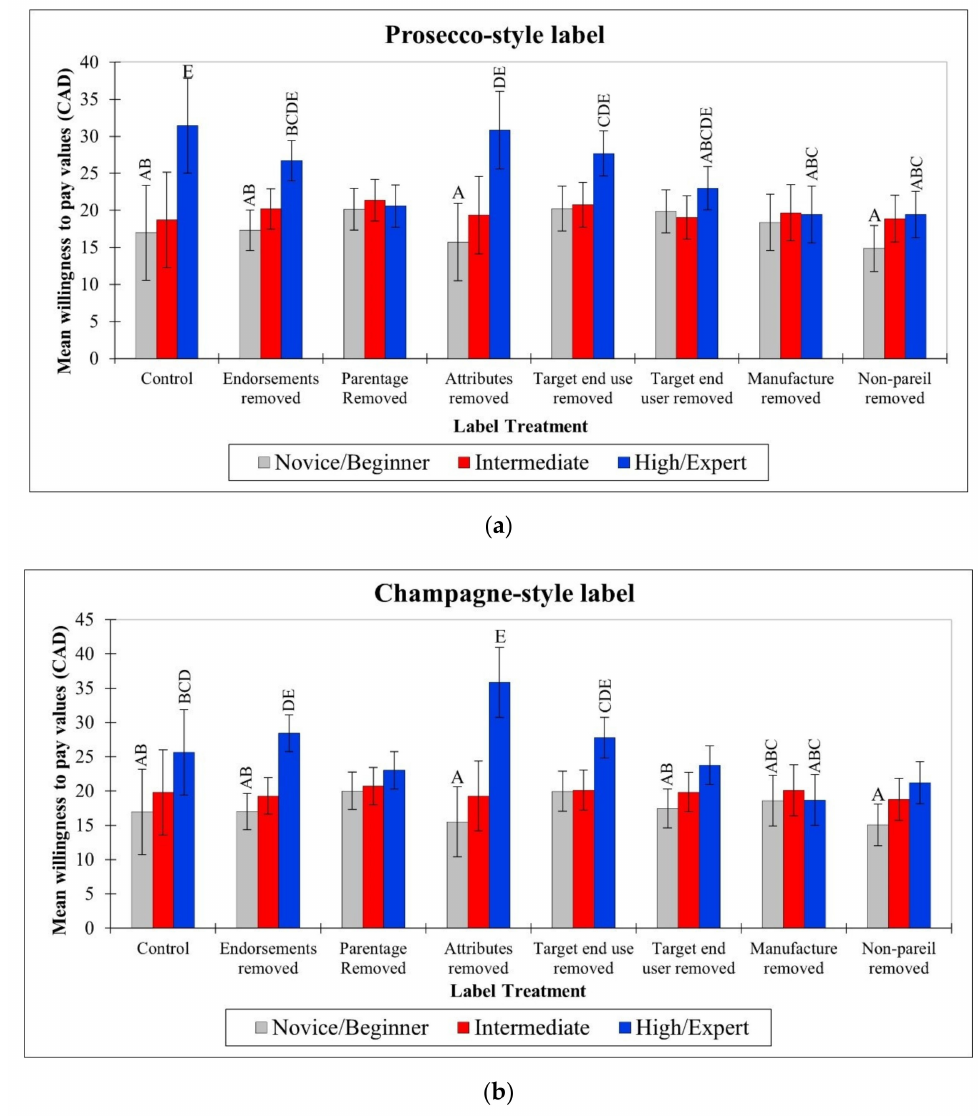
Figure 5. Willingness to pay (CAD, n = 572) +/ − SE for sparkling wine—interaction between label treatments and subjective wine knowledge. Results for ( a ) Prosecco-style wine and ( b ) Champagne- style wine. Letters above bars represent significantly different groups across all label treatments (Tukey’s (HSD 0.05 ) following two-way